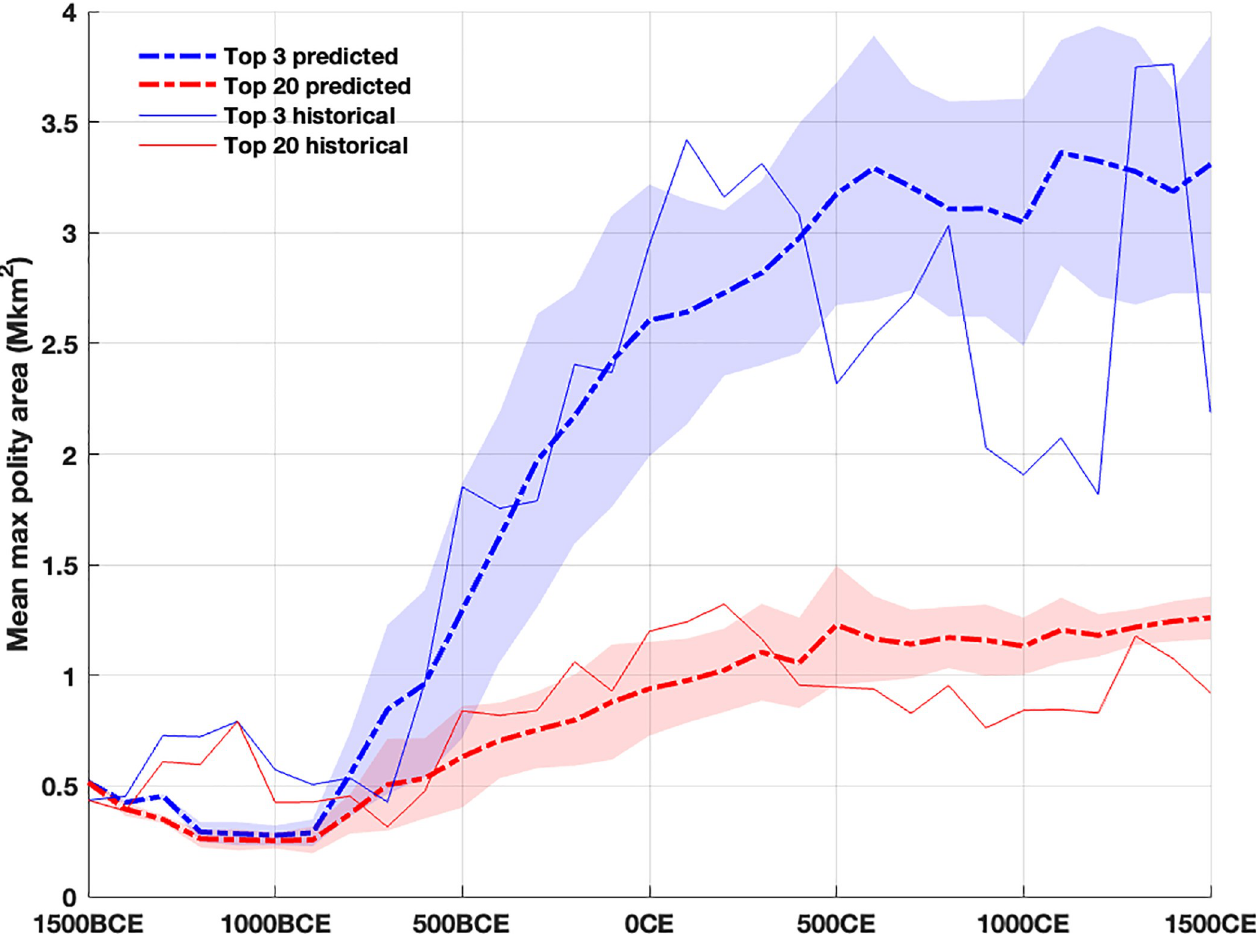
Fig 6. Polity size trends. Mean and standard deviation of predicted versus historical Old World polity sizes for the largest 3 and largest 20 states (agrarian and nomadic) between 1500 BCE and 1500 CE.